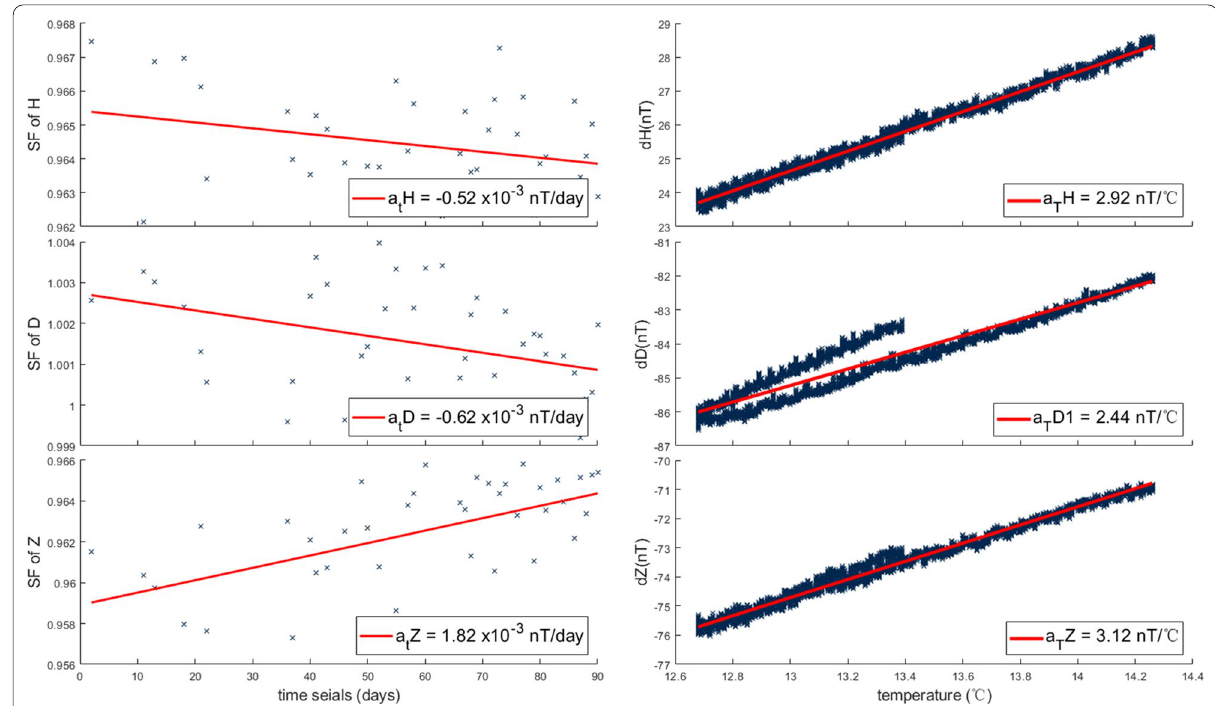
Fig. 5 Linear regression of the long-term time drift (left) and the relative temperature coefficient